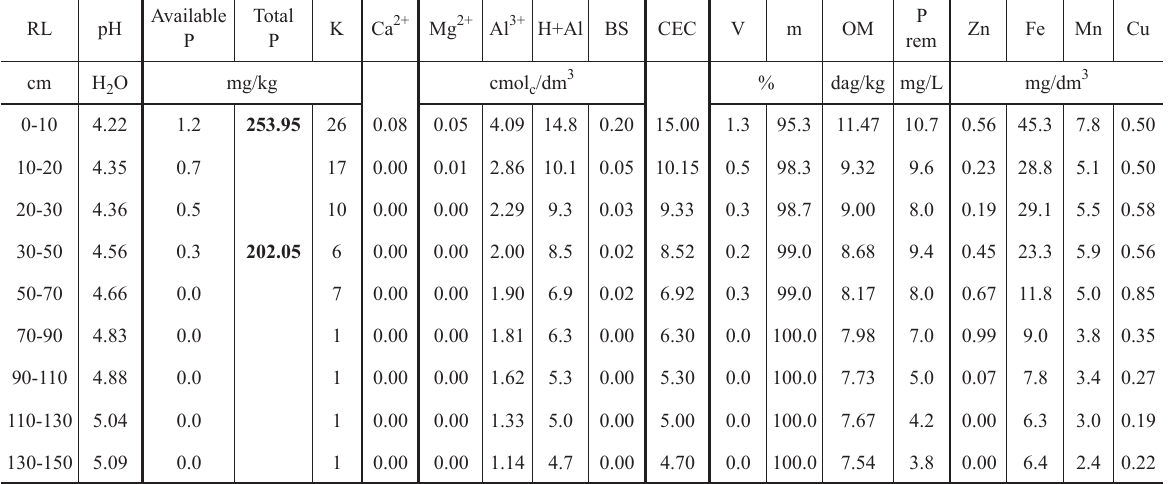
Color and morphological traits were obtained at 0-20cm and 40-60cm